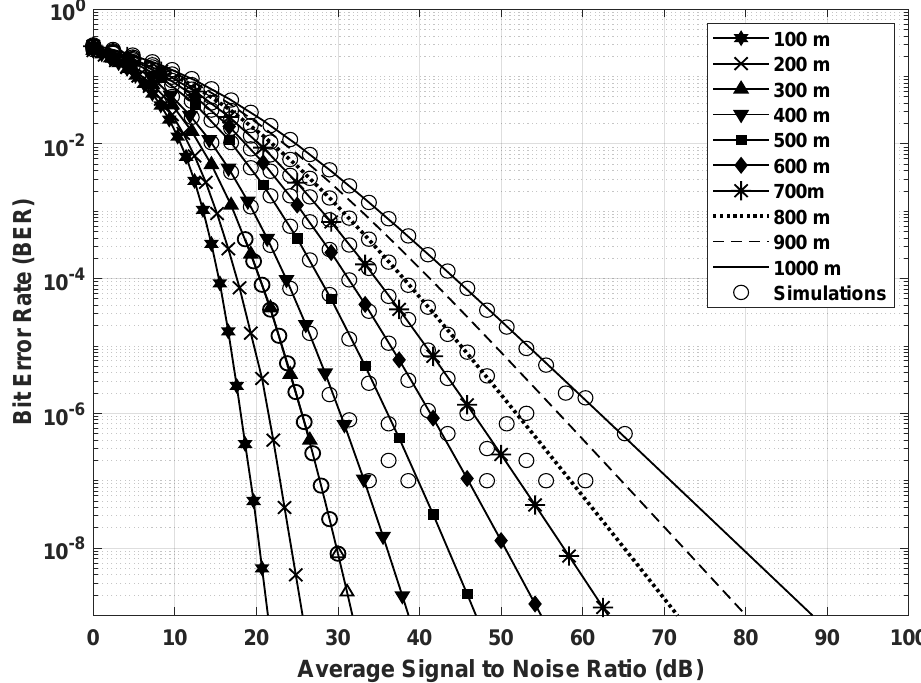
Figure 11. BER Performance for the Proposed System using OOK in Summer, Modeled using the G-G Channel, for Different Propagation